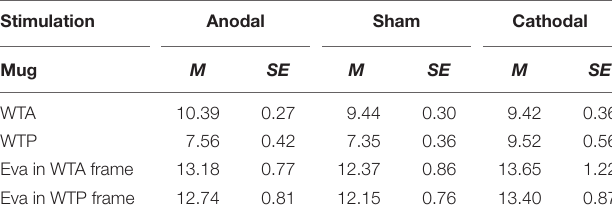
TABLE 1 | Means and standard errors of the data for the mug in Experiment 1. Stimulation Anodal